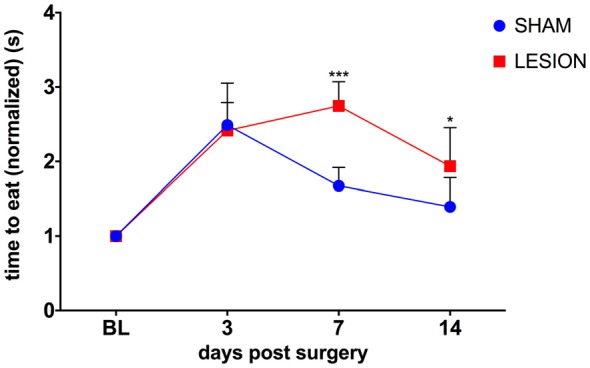
dCST lesion caused a transient decrease in the performance of the pasta test. Animals from the sham group recovered faster from the surgery than dCST-lesioned animals. The unilateral lesion of the dCST with ET-1 causes a more persistent deficit. ***p < 0.001, *p < 0.05. Two-way ANOVA, repeated measures, Tukey’s multiple comparisons test. Error bars represent mean ± SEM.